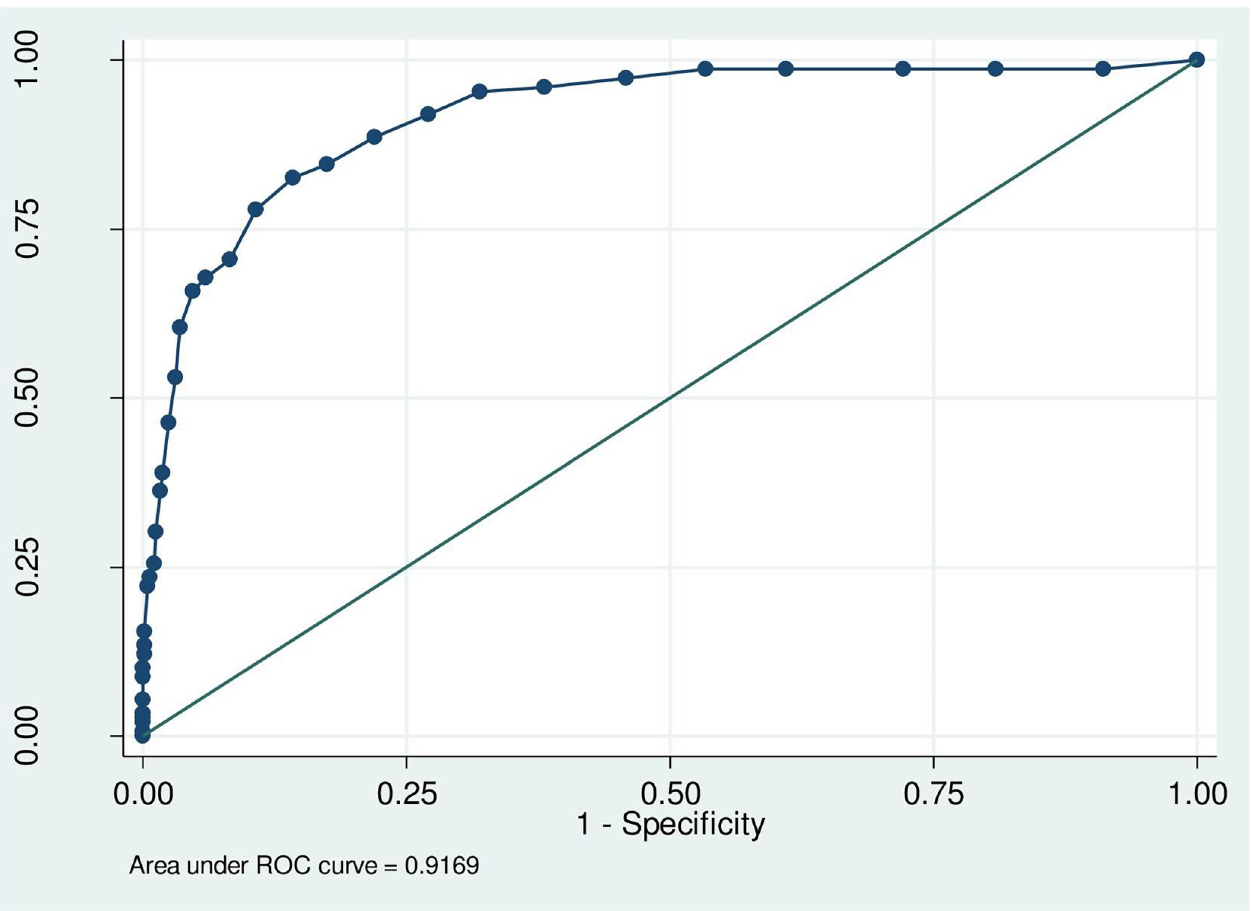
Fig 1. ROC curve analysis measuring predictive accuracy of HADS at baseline with CIS-R based diagnosis as the ‘ gold standard ’ . ROC: Receiver Operating Characteristic.